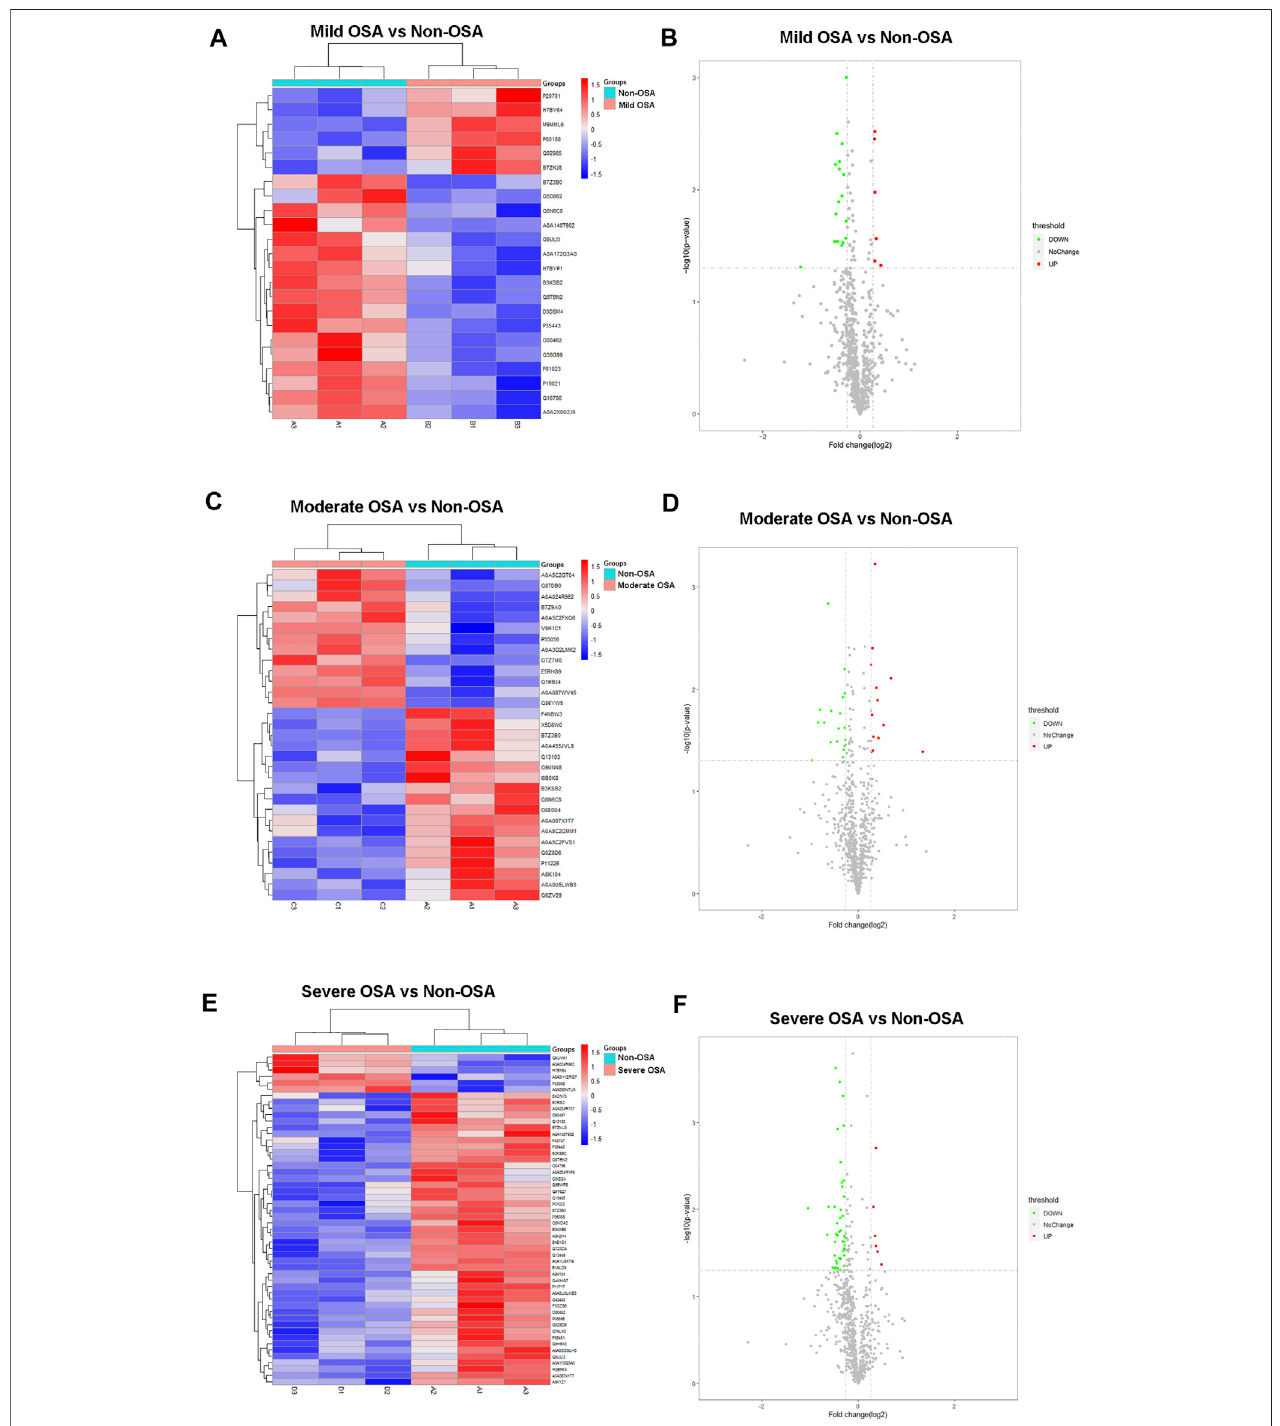
FIGURE3| Hierarchicalclusteranalysisandvolcanoplots: (A) hierarchicalclusteranalysisand (B) volcanoplotanalysisofdifferentiallyexpressedproteinsbetween the mild OSA group and non-OSA group, (C) hierarchical cluster analysis and (D) volcano plot analysis of differentially expressed proteins between the moderate OSA groupandnon-OSAgroup,and (E) hierarchicalclusteranalysisand (F) volcanoplotanalysisofdifferentiallyexpressedproteinsbetweenthesevereOSAgroupandnon- OSA group.